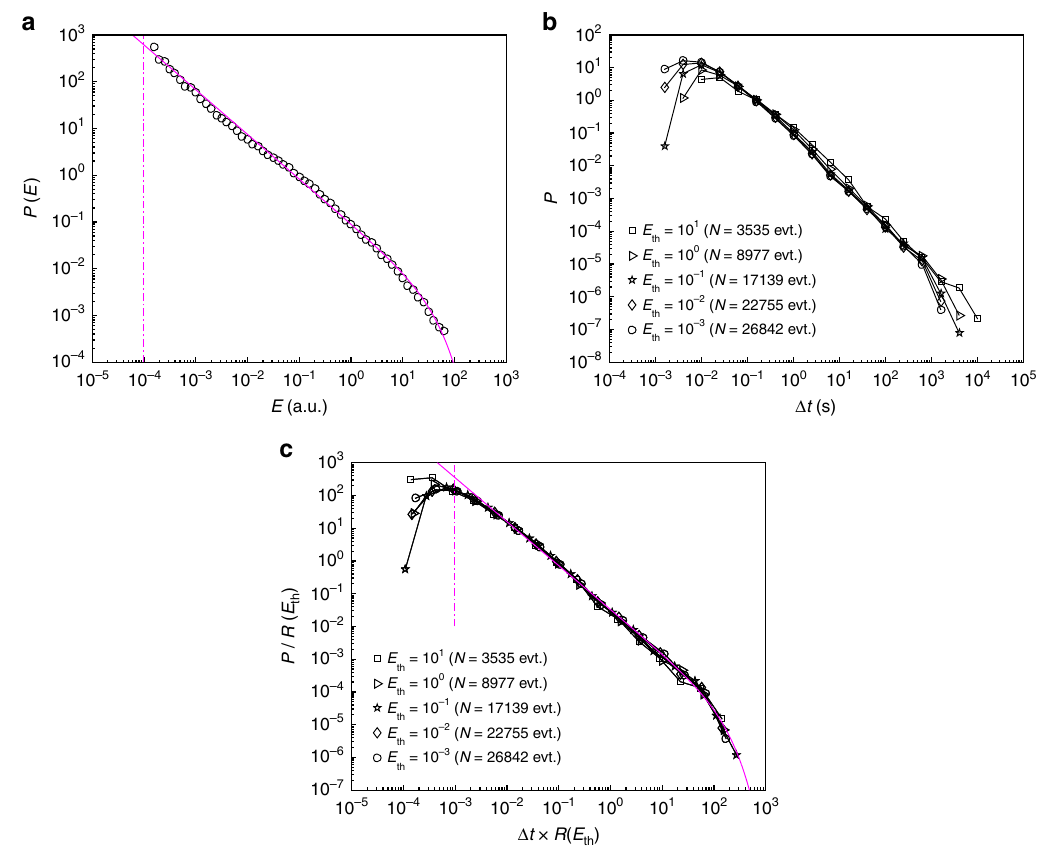
Fig. 2 The Gutenberg – Richter law and time – energy self-similarity. a Distribution of AE energy in one of the experiments (microstructure length-scale: d = 583 μ m, crack speed: (cid:1) v ¼ 2 : 7 μ ms (cid:2) 1 ). Solid magenta line is a gamma function P ( E ) ∝ E − β exp ( − E / E 0 ) for E ≥ E min = 10 − 4 (vertical magenta dashed line), with fi tted parameters β = 0.96 ± 0.02 and E 0 = 38 ± 9. b Distribution of the time interval Δ t separating two successive AE of energy larger than a prescribed energy threshold, E th . c Collapse obtained after having rescaled Δ t with the mean activity rate R ( E th ) = N ( E th )/ T , where N ( E th ) is the number of AE with E ≥ E th and T = 31080 s is the total duration of the fracture experiment. Magenta -curve is the gamma function f ( x ) ∝ x − γ exp ( − x / B ) with x ≥ b with fi tted parameters γ = 1.34 ± 0.03, B = 109 ± 20, and b = 1 ± 0.9 × 10 − 3 . ± stands for 95% con fi dence interval. In all panels, axes are